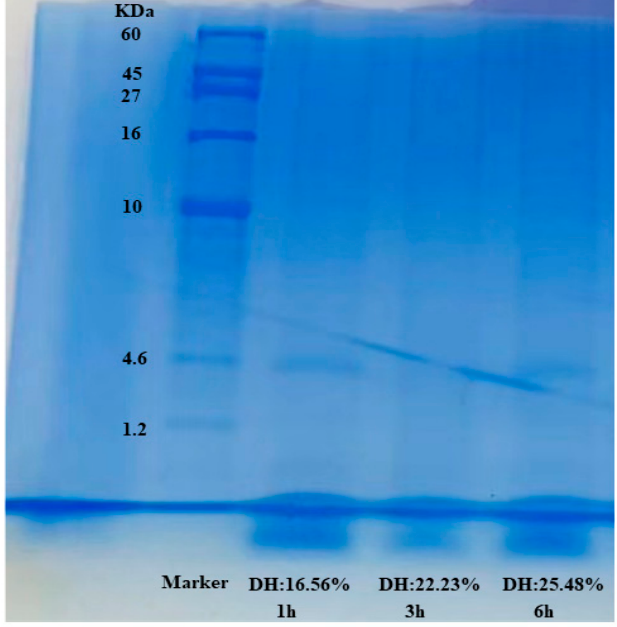
Figure 4. SDS-PAGE pattern of protein hydrolysates under different degrees of Figure 4. SDS ‐ PAGE pattern of protein hydrolysates under different degrees of hydrolysis.